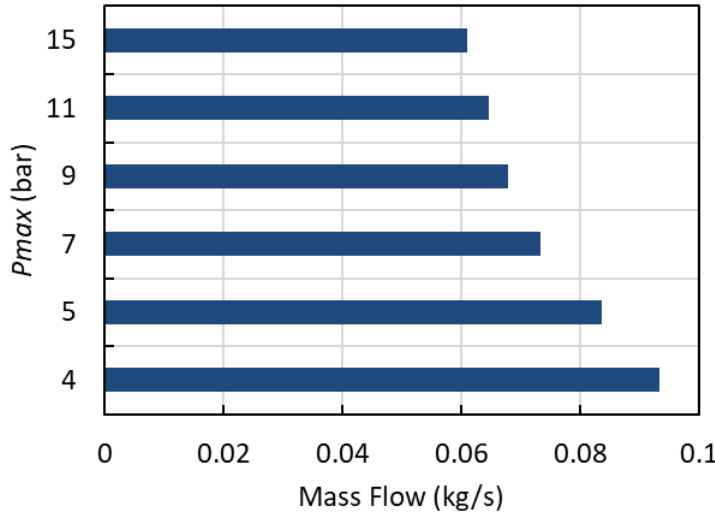
Figure 16. Variation of air mass flow rate with the maximum pressure.